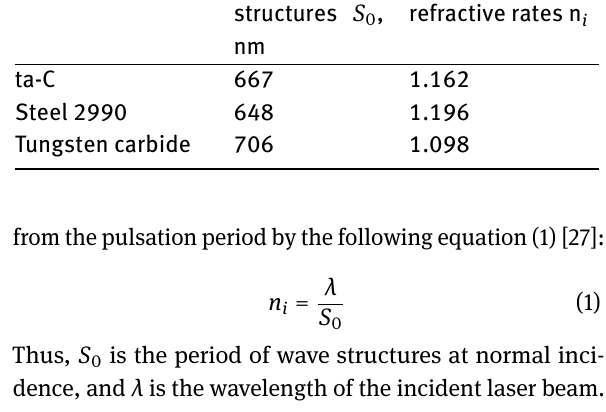
Table 1: The dependence of the measured periods of pulsations on the average laser wavelength, density of the stream, and the number of laser pulses Material